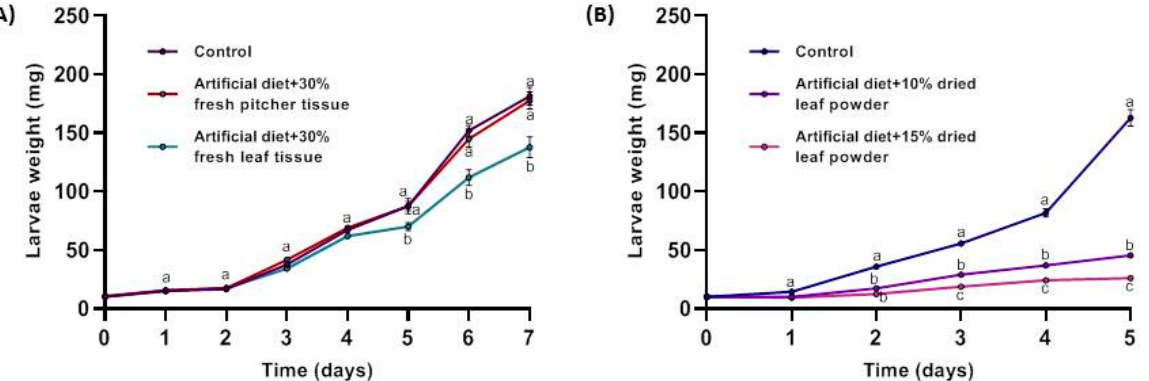
Figure 2. Performance of Spodoptera littoralis larvae feeding on artificial diet containing ( A ) fresh leaf powder of Nepenthes x ventrata leaf and pitcher (30% ( w / w )) or ( B ) dried N. x ventrata leaf powder (10 and 15% ( w / w )) Larvae were weighed every day for 7 days. Mean ( ± SE) labelled with different letters indicate significant difference ( p < 0.05); two-way ANOVA, Šid á k’s multiple comparisons test; n = 15.